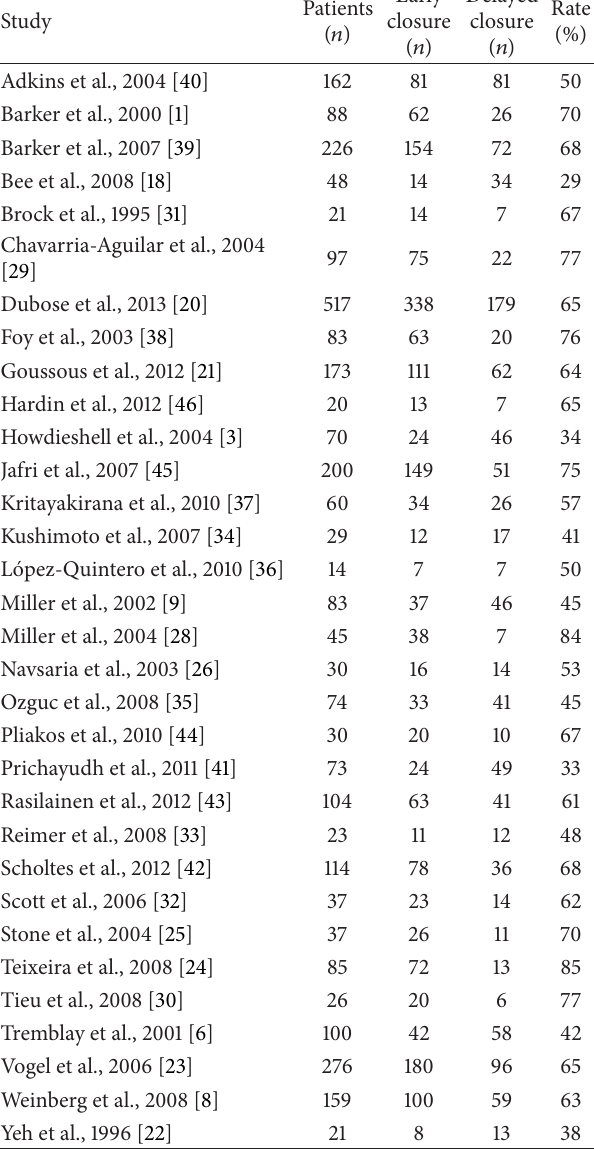
Table 1: Early fascial closure rate of all enrolled